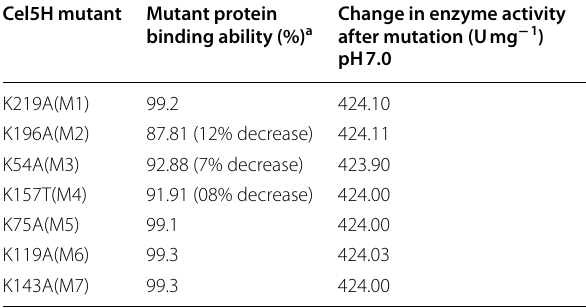
a change in binding capacity [compared to wild-type (99.5%)] is calculated as mentioned in our previous article (Math et al. 2019)